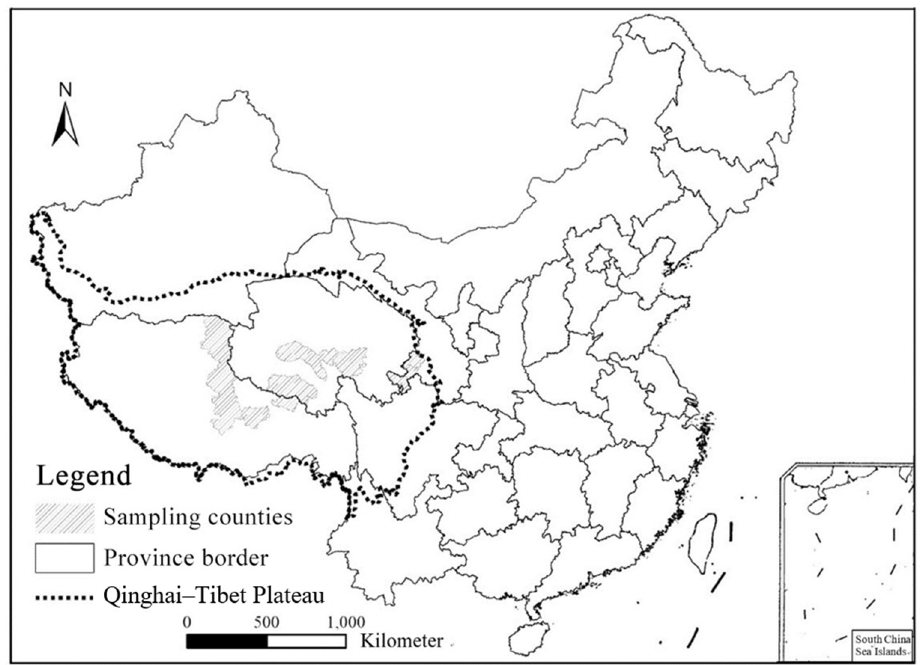
Figure 2. Study area.